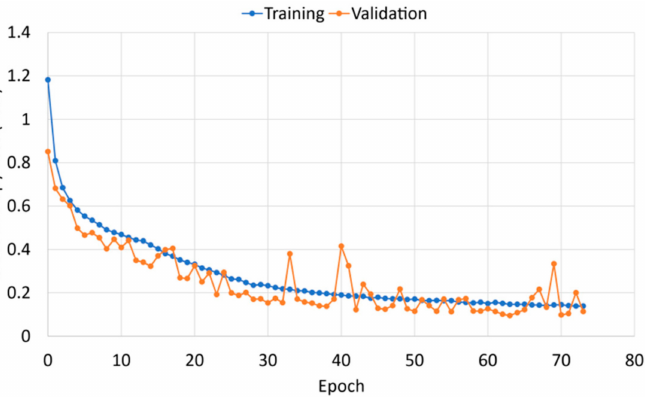
Figure 3. Training curve of a BiLSTM with an attention mechanism. The lowest validation loss occurs at epoch 63 and this model is